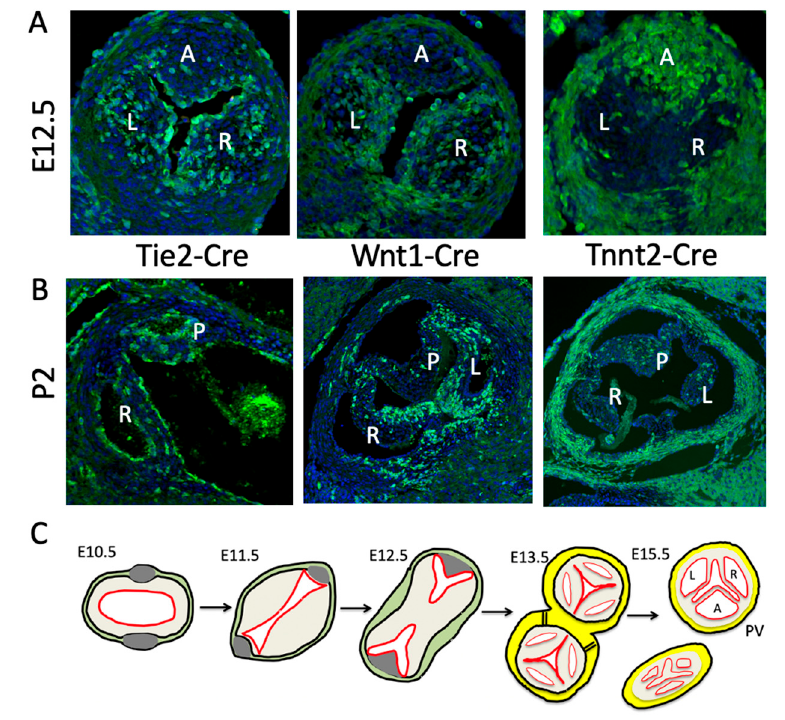
Figure 3. Lineage tracing of cells in the foetal and neonatal arterial valves. ( A ) At E12.5, Tie2-Cre labelled endocardial-derived cells, Wnt1-Cre -labelled NCC and Tnnt2-Cre labelled cells derived directly from the SHF, via the outflow wall, are found within the pulmonary valve leaflet primordia. Whilst Tie2-Cre and Wnt1-Cre -labelled cells are most abundant in the left (L) and right (R) leaflets, the Tnnt2-Cre labelled cells are the most abundant in the anterior (A) leaflet derived from the ICVS. Similar observations are made for the aortic valve (not shown). ( B ) At P2, each of the three lineages of cells are maintained within the leaflets of the aortic valve. As at E12.5, Wnt1-Cre and Tie2-Cre labelled cells are most abundant in the L and R leaflets, whilst Tnnt2-Cre labelled cells are most abundant in the posterior (P) leaflet derived from the ICVS. Similar observations are made for the pulmonary valve (not shown). ( C ) Cartoon illustrating how arterial valve leaflet formation is intimately linked to outflow tract septation. At E10.5, the forming endocardial cushions (buff coloured) are circumferential within the outflow vessel and the ICVS (grey) can first be seen within the outflow wall (green). By E11.5 the endocardial cushions (buff) have expanded and are coming together to fuse in the midline. Fusion of these cushions separates the outflow tract and gives rise to the L and R valve primordia. The ICVS give rise to the A and P valve primordia. By E13.5 the aortic and pulmonary valve are distinct, and the sinuses are beginning to appear. At E15.5, valve sculpting is almost complete, and the aorta and pulmonary valves are offset. Green = myocardium, yellow = SMC, red = endocardium.